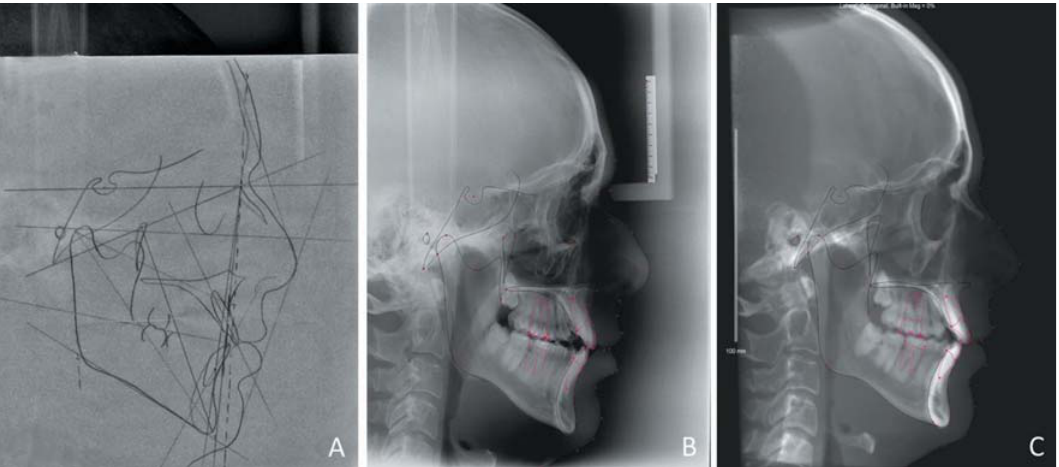
Figure 3- A) Manual tracing; B) Digitized lateral cephalograms; C) Lateral cephalograms from cone-beam